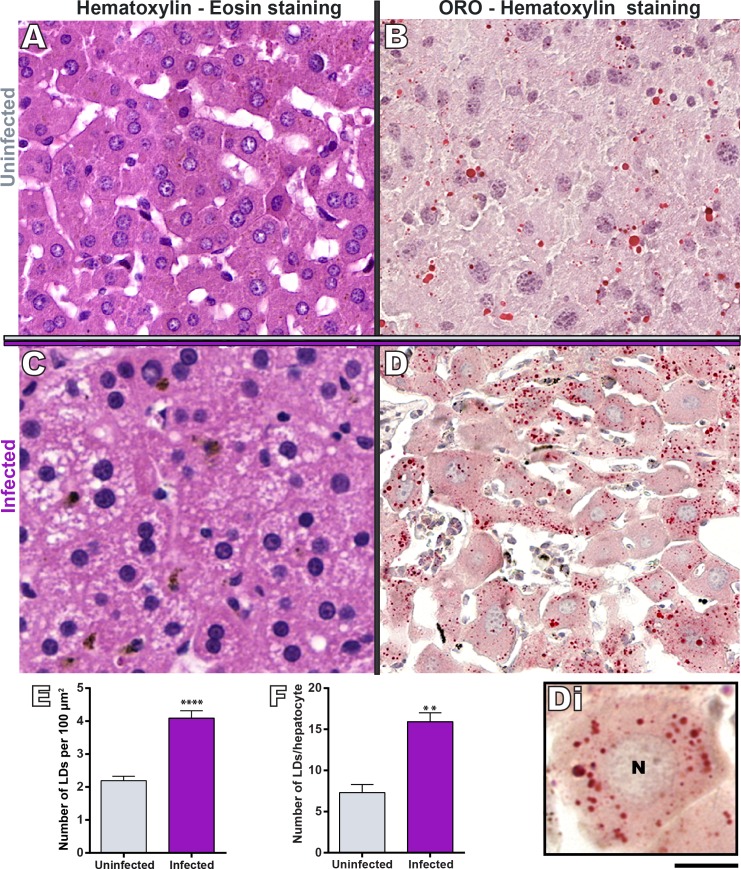
Excessive LD accumulation occurs in the liver of naturally S. mansoni-infected N. squamipes.In (A and C), the hepatic tissue shows putative LDs, negatively stained with alcoholic hematoxylin-eosin. (B and D), ORO staining confirms the presence of numerous LDs seen as round organelles (stained in red) and distributed within hepatocytes. In (Di), a hepatocyte is seen in high magnification. (E, F) Quantitative analyses of LD numbers in the hepatic tissue. ORO staining was performed on cryosections from liver fragments fixed in buffered paraformaldehyde. LD quantifications were done in a slide scanner using Pannoramic Viewer and Histoquant softwares. A total of 1,500,000 μm2 of tissue area was evaluated per animal, with a total of 4,500,000 μm2 of tissue area analyzed per group (n = 3 animals). Data represent mean ± S.E.M. ****P < 0.0001, ** P < 0.004 versus uninfected group. Scale bar, 40 μm (A,D); 50 μm (B); 75 μm (C); 8 μm (Di).